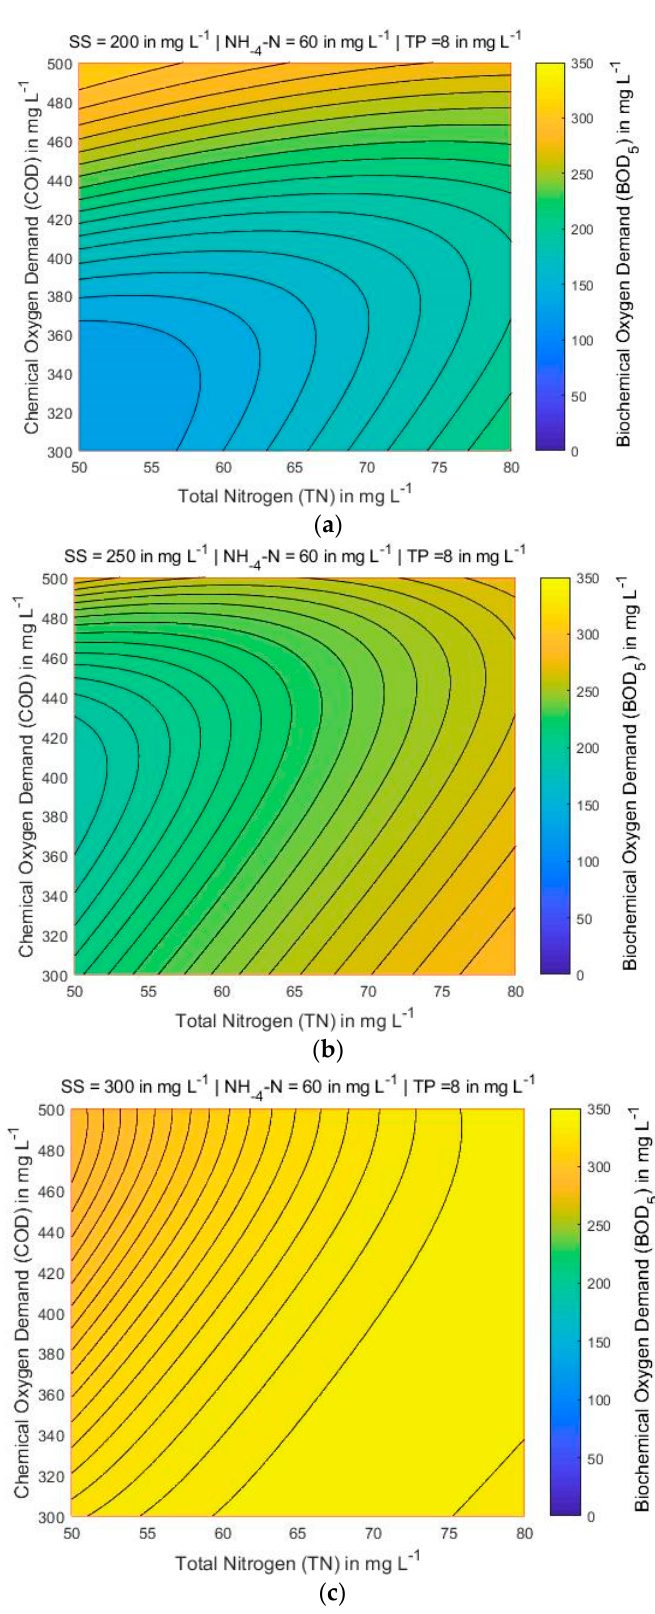
Figure 7. BOD 5 contour maps for three different values of SS (in mg L − 1 ) while NH 4 -N = 60 mg L − 1 and TP = 8 mg L − 1 are constant: ( a ) SS = 200; ( b ) SS = 250; and ( c ) SS= 300.